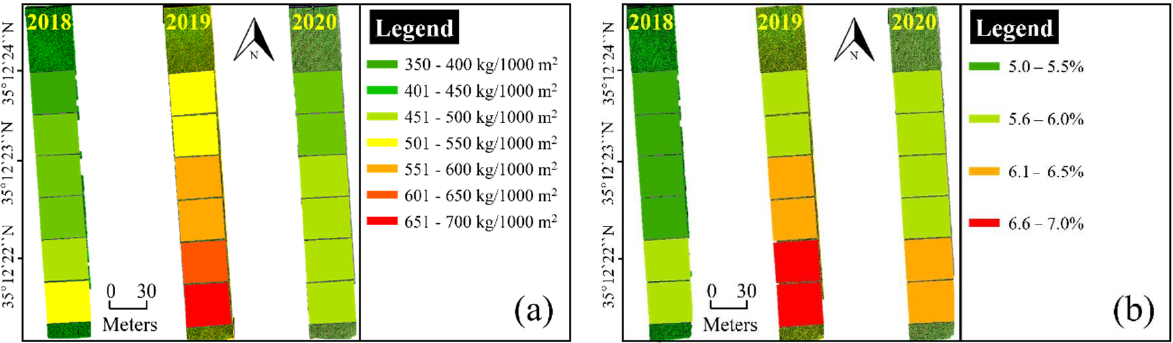
Figure 6. Maps of the predicted ( a ) rice yield and ( b ) protein content with ANN models for multiple years.